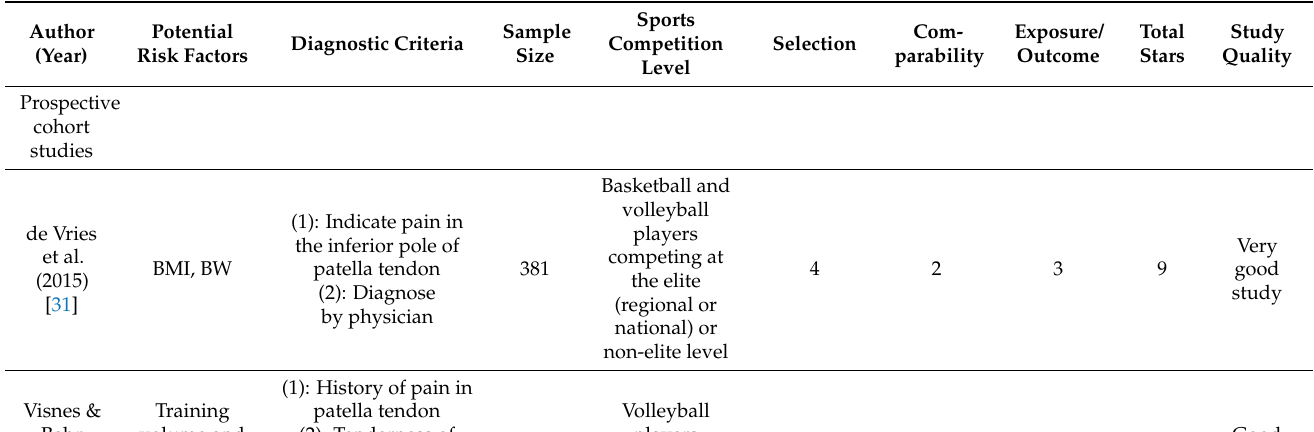
Table 2. Detailed summary of critical appraisal of included studies using the adapted-version